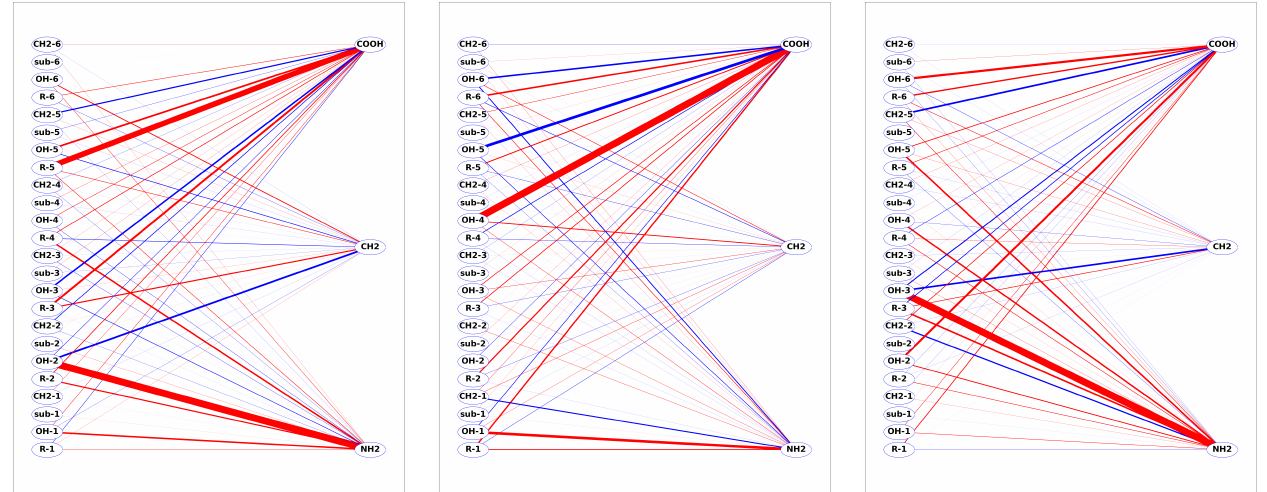
Figure 6. The F-SAPT interaction energy graph for the Gly amino acid interacting with the al - CX (leftmost graph), pc -CX (middle graph), and wc -CX (rightmost graph). Calixarene functional groups are depicted on the left and those for Gly–on the right. The red (blue) lines denote attraction (repulsion), and their thickness is proportional to the interaction